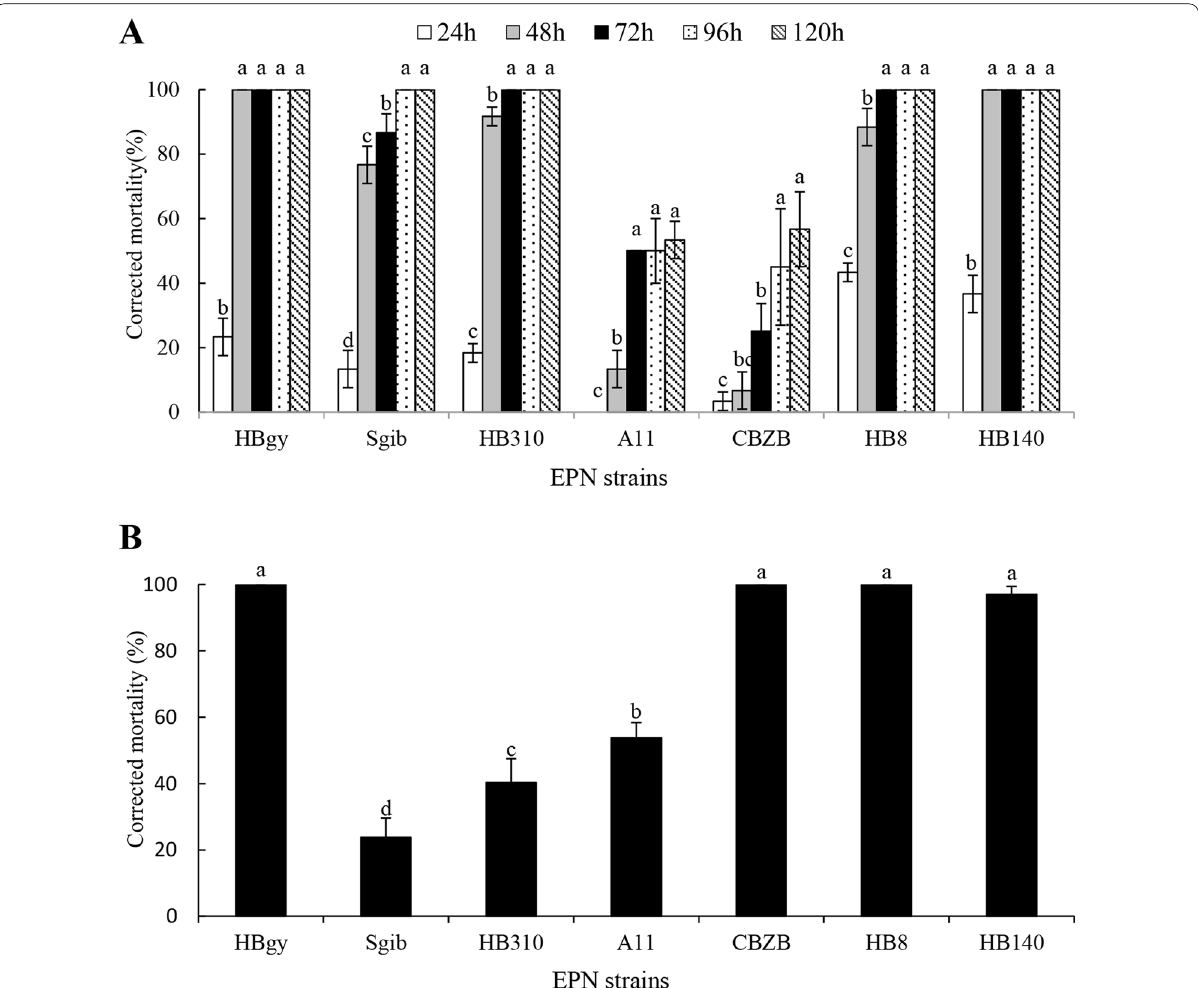
Fig. 1 Pathogenicity and desiccation tolerance of seven EPN strains on Atrijuglans hetaohei . A Corrected mortality of A. hetaohei larvae caused by seven EPN strains. B Corrected mortality of different EPN strains in anti-desiccation assays. HBgy Steinernema glaseri , Sgib Steinernema = = glaseri , HB310 Steinernema carpocapsae , All Steinernema carpocapsae , CBZB Steinernema longicaudum , HB8 Heterorhabditis bacteriophora , = = = = HB140 Heterorhabditis bacteriophora . Differing letters indicate values significantly different from one another at the p < 0.05 level (Tukey’s HSD =